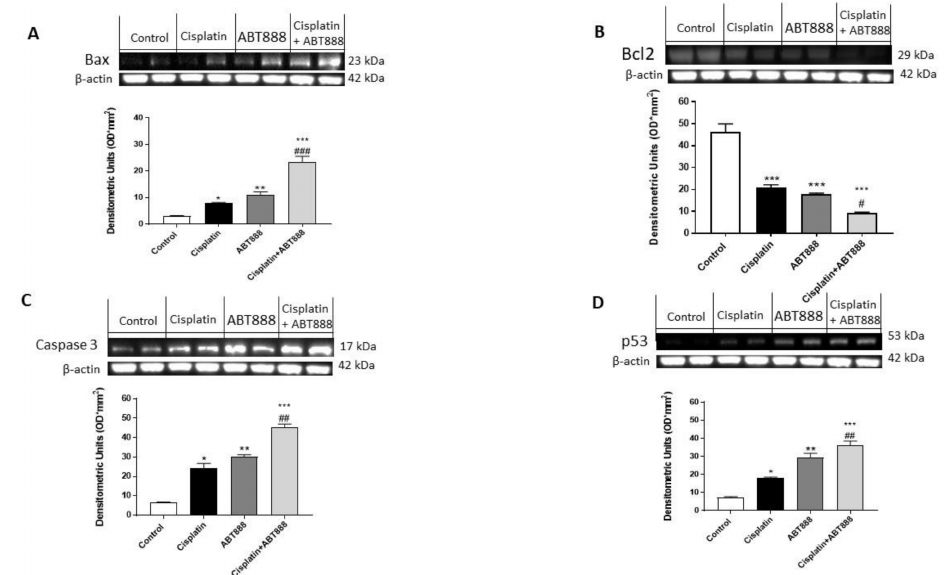
Figure 3. Effect of ABT888 and cisplatin on apoptosis pathway in CAL27 cell line. The blots revealed an increase in Bax, caspase-3 and p53 expression in the combination group of ABT888 and cisplatin, as shown in Figures A , C and D , respectively, compared to the single treatments and control group. On the contrary, the expression of Bcl2 was significantly reduced in the combinatory treatment of ABT888 and cis-platin, compared to the single treatments and control group, as shown in Figure B. ( A ) * p < 0.05, ** p < 0.01, *** p < 0.001 vs. the control; ### p < 0.001 vs. cisplatin group. ( B ) *** p < 0.001 vs. the control; # p < 0.05 vs. cisplatin group. ( C ) * p < 0.05, ** p < 0.01, *** p < 0.001 vs. the control; ## p < 0.01 vs. cisplatin